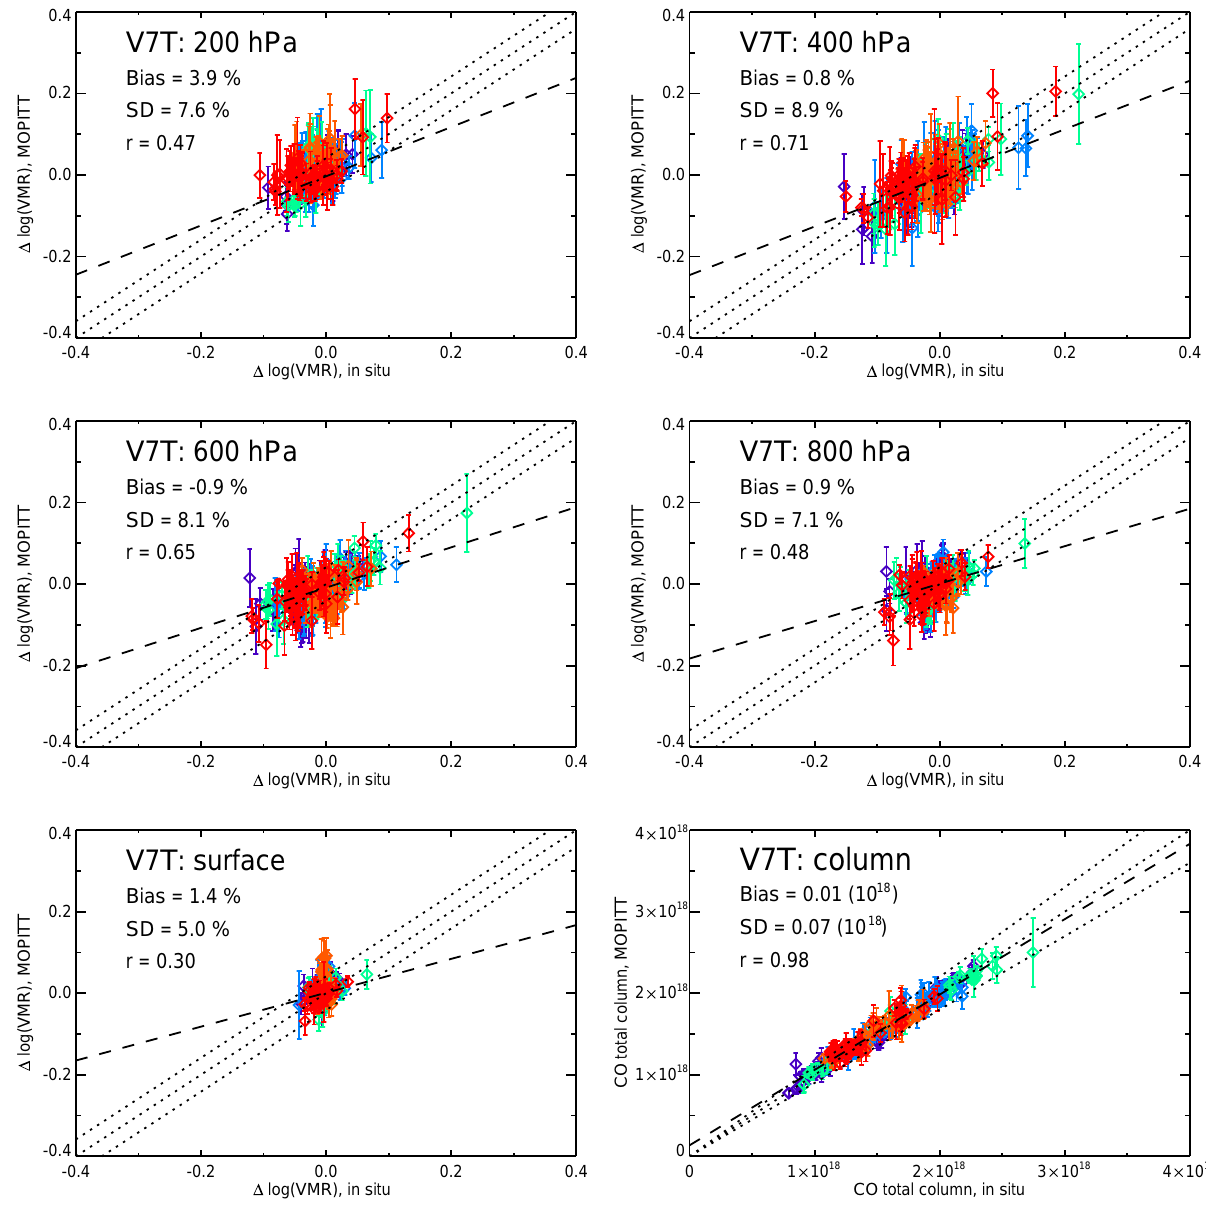
Figure 10. V7 TIR-only validation results based on the HIPPO in situ profiles. See caption to Fig. 3.